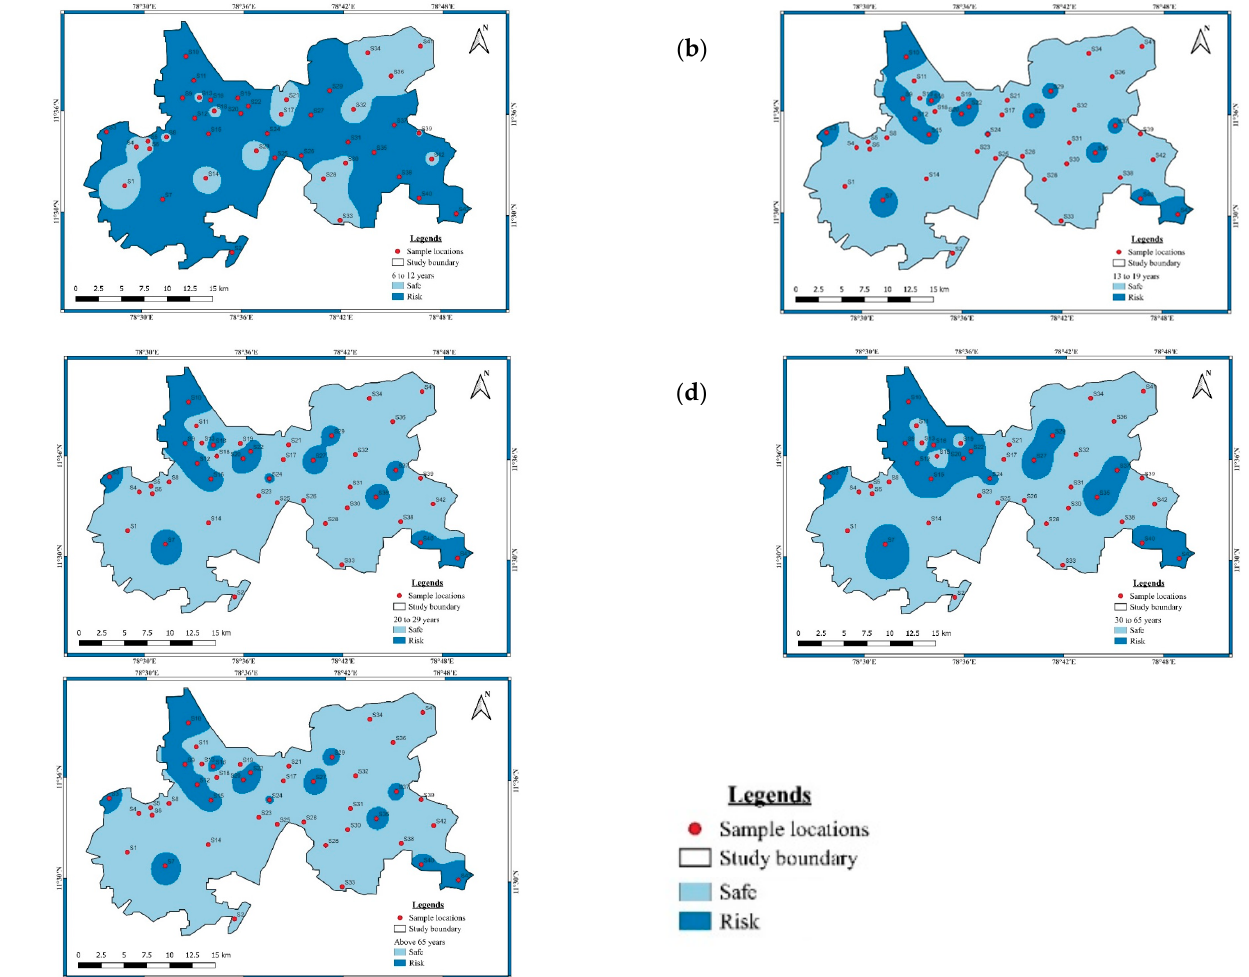
Figure 7. Non-carcinogenic risks for those aged: ( a ) 6–12 years; ( b ) 13–19 years; ( c ) 20–29 years; ( d ) 30–65 years; ( e ) over 65 years.